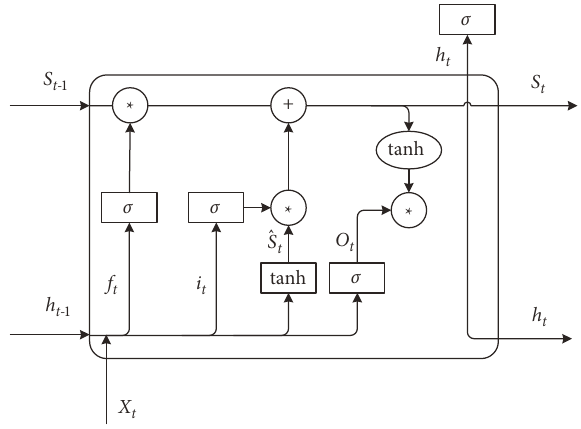
Figure 7: Structure diagram of the LSTM